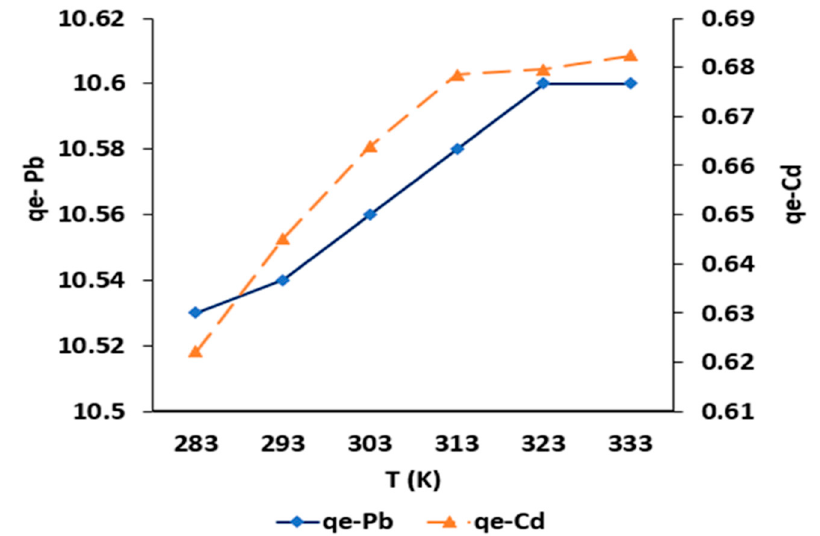
Figure 7. Impact of temperature on the q e .